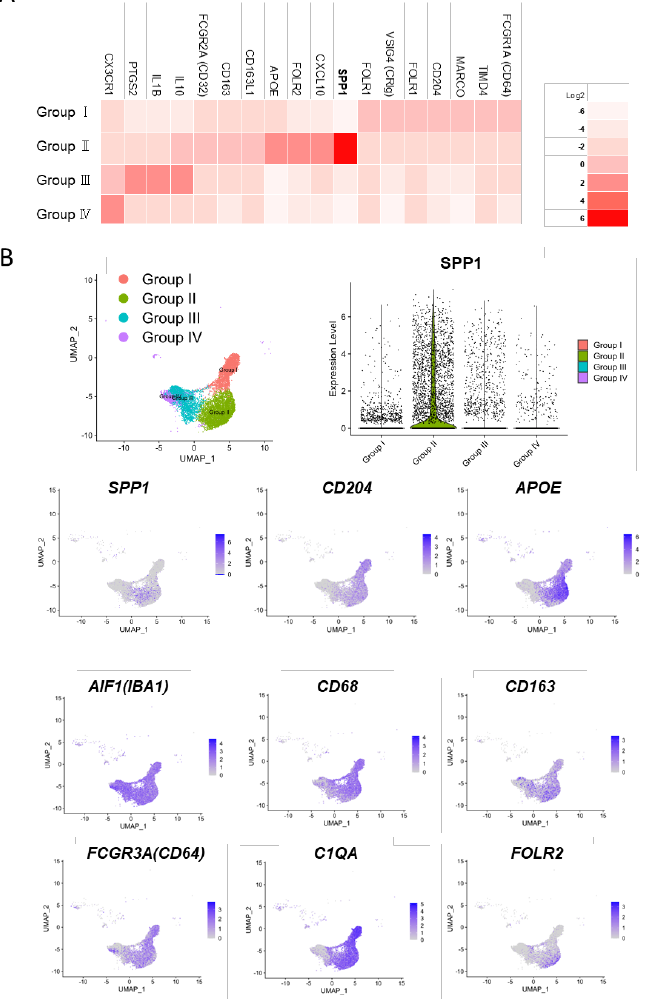
Figure 2. Analysis of single-cell RNA-sequence data of NSCLC. ( A ) Re-analysis of published single-cell RNA sequence data for NSCLC (BioProject accession; PRJNA609924) [68]. Heatmap of the ex- pressions of selected genes in macrophages and monocytes of Groups I, II, III, and IV (tissue-resi- dent macrophages, monocyte-derived macrophages, CD14+ monocytes, and CD16+ monocytes) based on data from an original report examining 30 NSCLC cases. ( B ) UMAP plots of macrophage and monocyte populations (Groups I, II, III, and IV) based on 9 selected cases of adenocarcinoma among the 30 abovementioned NSCLC cases. Expression levels of SPP1 across the four groups are summarized using a violin plot. Expression levels of SPP1, CD204 (MSR1), AIF1 (IBA1), CD68, CD163, FCGR3A, C1QA, FOLR2, and APOE across the four populations, with intensity represented in purple in UMAP plots. Cells are grouped as per the method of the original report.